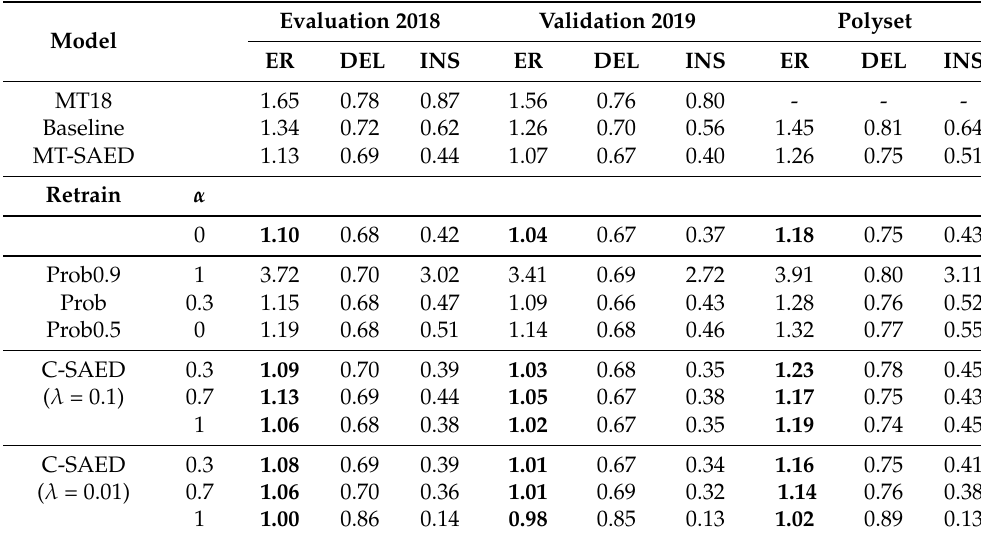
Table 1. Comparison of models in terms of ER (%). Retraining with α = 0 is equal to retrain without confidence. We bold the reduced ER value after retraining.